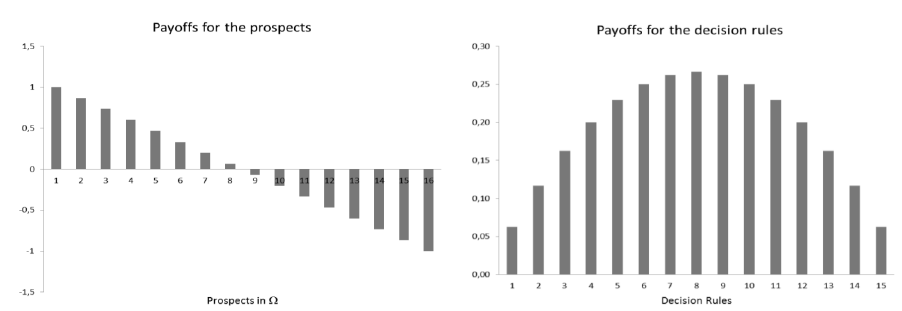
Standard model of the ecosystem: k = 4 , P ∗ (Ω) = 2 − k